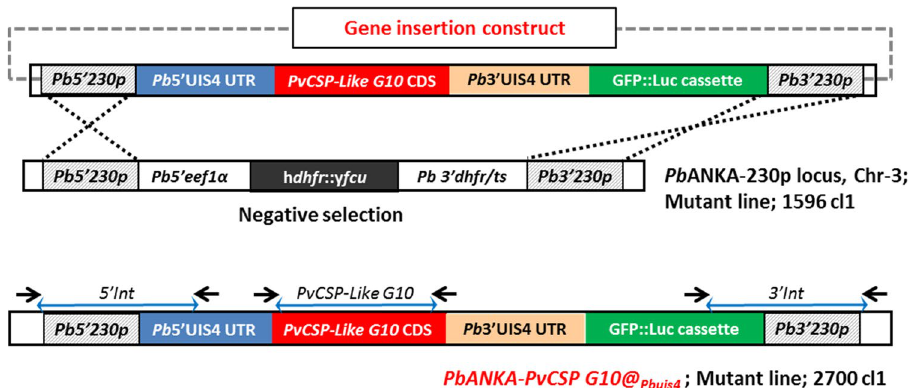
Figure 3. Strategy to generate a chimeric P. berghei parasite line expressing a PvCSP-P. vivax-like protein as additional CSP. An additional copy line in which the Pv CSP- P. vivax -like CDS (PVU09738) gene was introduced into the genome as an additional copy of the gene in the neutral 230p locus. The construct that contains the ‘ Pv CSP- P. vivax -like gene expression cassette’ was integrated into the 230p locus on chromosome 3 of the P. berghei ANKA GIMO mother line by GIMO transfection using negative selection (5-FC), resulting in the expression of the Pv CSP- P. vivax -like gene under the control of the Pbuis4 gene promoter and transcriptional terminator sequences. This construct also expresses a GFP and firefly luciferase (LUC-IAV) fusion protein under control of the constitutive Pbeef1a promoter and is selectable marker (SM)-free. The construct is integrated into the neutral p230p locus by double crossover integration. Black arrows: location of PCR primers used for the diagnostic PCR